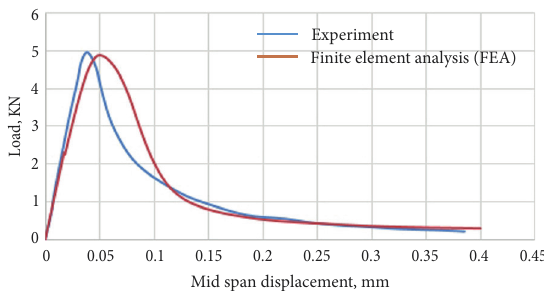
Fig. 25. Comparison load-displacement response: experimental (Le Bellego et al. 2003) and finite element analysis (FEA) in three-point notch beam with large